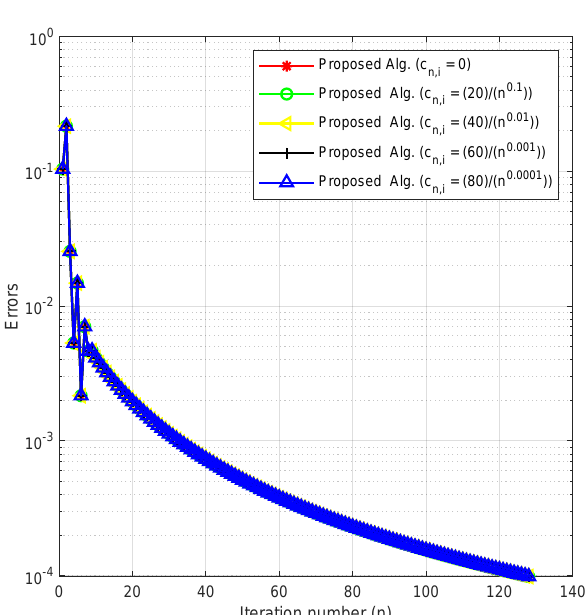
Figure 6. Experiment 2: Case 2.